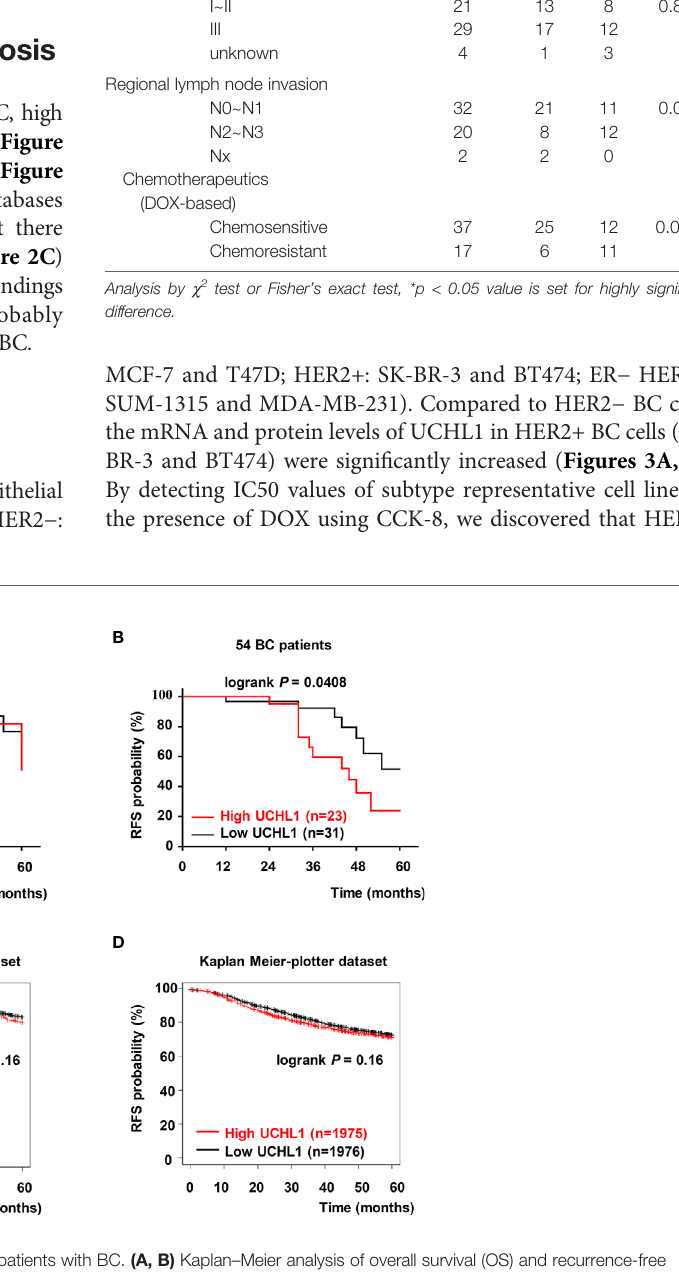
FIGURE 2 | Upregulation of UCHL1 correlated with poor prognosis in patients with BC. (A, B) Kaplan – Meier analysis of overall survival (OS) and recurrence-free survival (RFS) in 54 patients with BC based on UCHL1 expression are indicated. OS and RFS were determined according to UCHL1 expression in BC samples from the public Kaplan – Meier-plotter dataset (C, D) . Statistical analysis was carried out by Log-rank